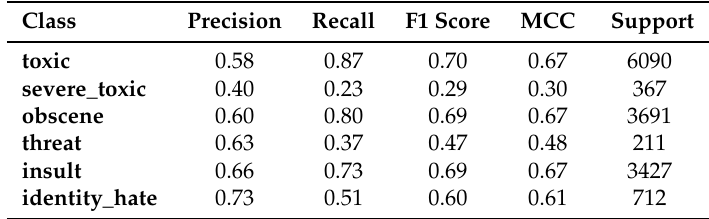
Table 16. Results of the individual toxicity classes of bare BERT uncased model after fine-tuning. Class Precision Recall F1 Score